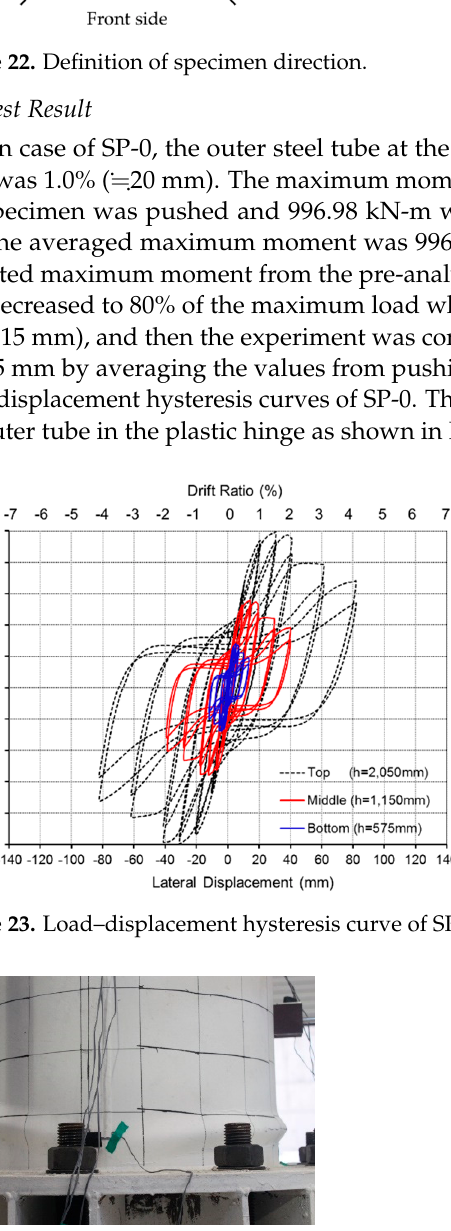
Figure 24. Buckling failure of outer tube of PS-0.